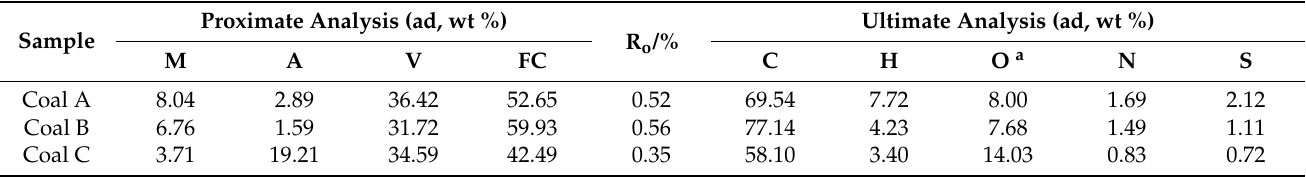
Table 1. The proximate and ultimate analyses of raw